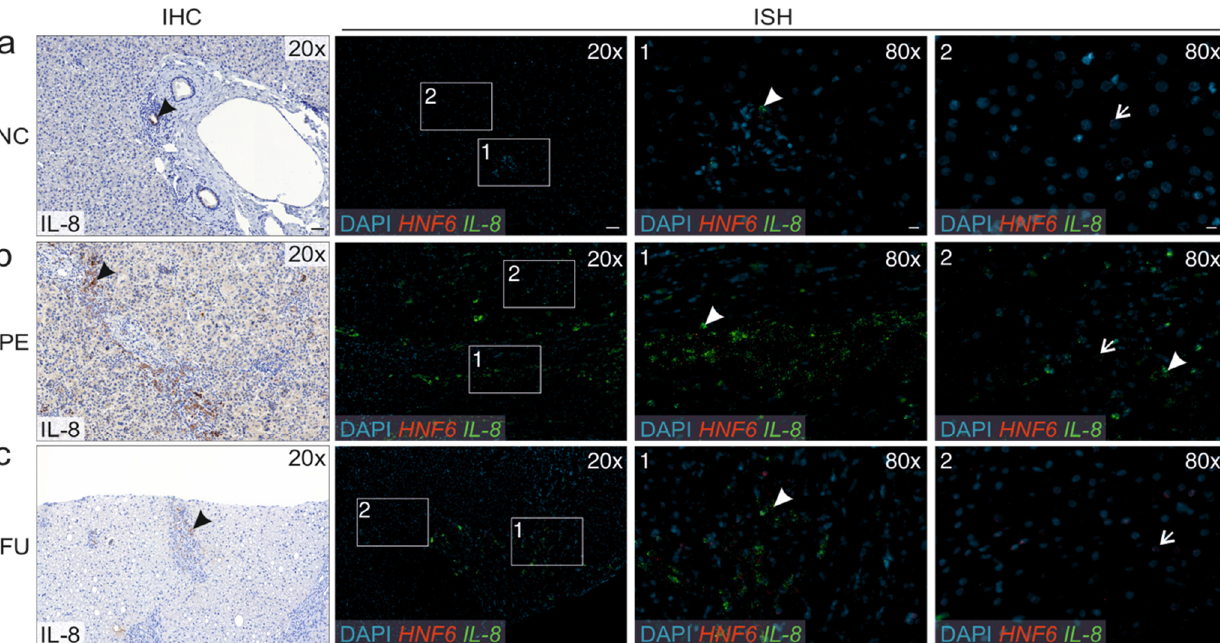
Figure 2. Representative liver expression of IL-8 on immunohistochemistry (IHC) and in situ hybridization (ISH) in ( a ) normal control (NC), ( b ) biliary atresia patient at portoenterostomy (PE) and ( c ) during follow-up (FU) after PE. ISH includes two magnified images (80×) from each of the original (20×) image focused on (1) the area of ductular reaction (DR) and (2) hepatocyte rich parenchymal area. Arrow heads (black and white filled) point to IL-8 expressing cells (brown in IHC and green in ISH) while arrows (white filled) point to a hepatocyte marker HNF6 expressing cells in ISH. Note the expression of IL-8 in bile duct cholangiocytes in the normal liver, while IL-8 is strongly expressed in the DR area and cholangiocytes instead of hepatocytes in biliary atresia patients. Scale bar = 50 μ m (20×)/10 μ m (80×)